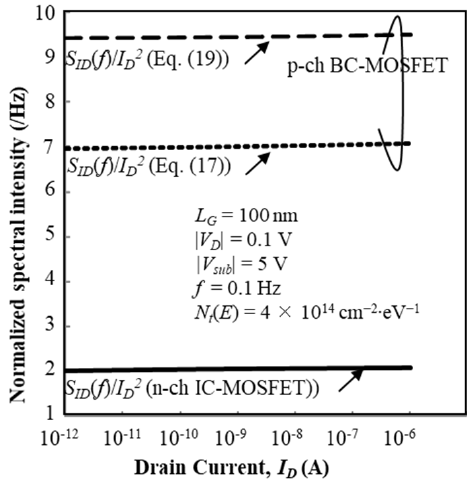
2 as a function of I ( f ) / I D D for p-channel BC-MOSFET. It is 2 ( ) S f I as a function of I D D for p-channel BC-MOSFET. It is D I D 2 ( ) S f I as a function of I D for p-channel BC-MOSFET. It is D I D